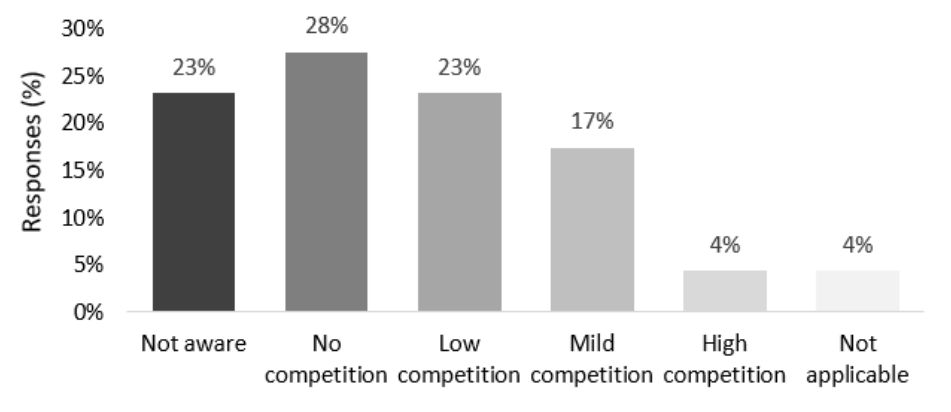
Figure 9. Respondents’ perceptions of competition set by semifinished products and end-products made of timber coming from the windstorm that are not labeled PEFC Fair supply chain.